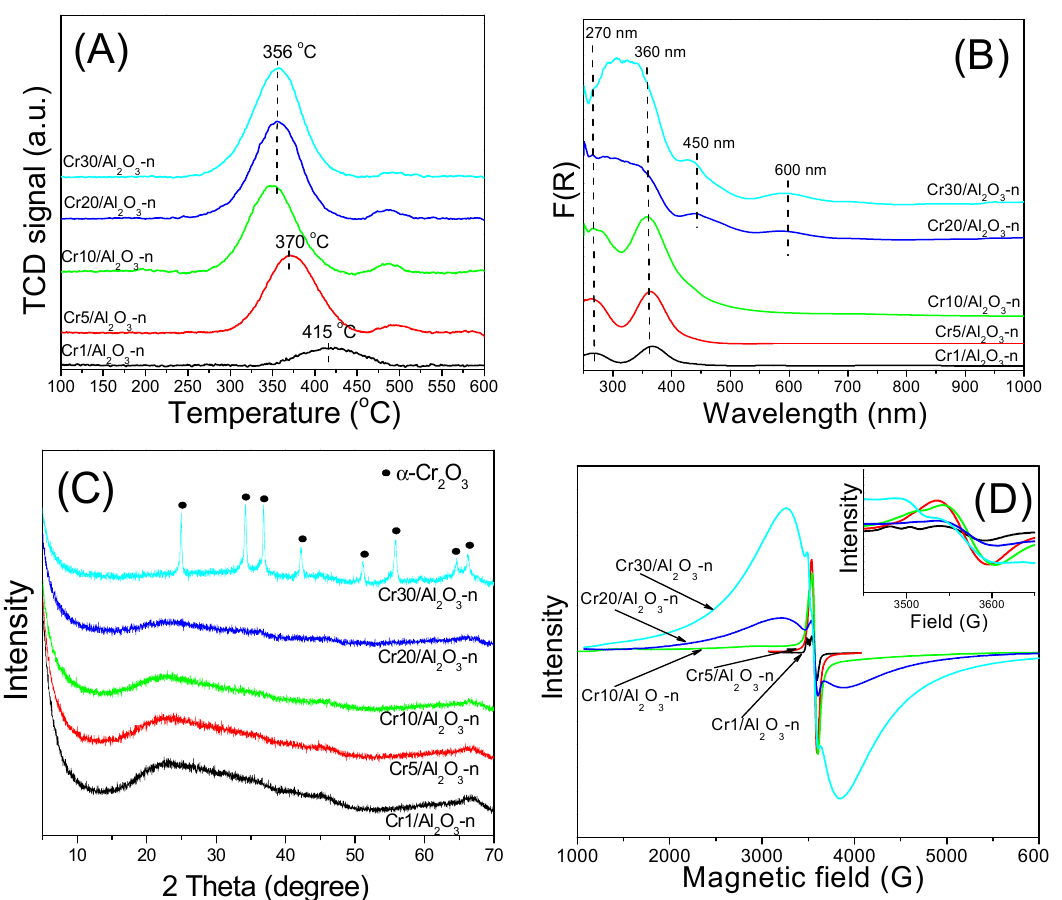
Figure 3. H 2 -TPR profiles ( A ); UV-Vis DRS spectra ( B ); XRD patterns ( C ); and electron paramagnetic resonance (EPR) spectra ( D ) measured for Cr x /Al 2 O 3 -n catalysts.